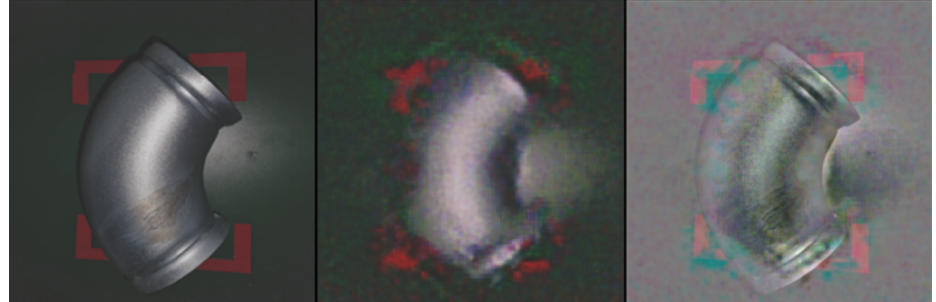
Figure 10. Bottom Crack Image Data Comparison.